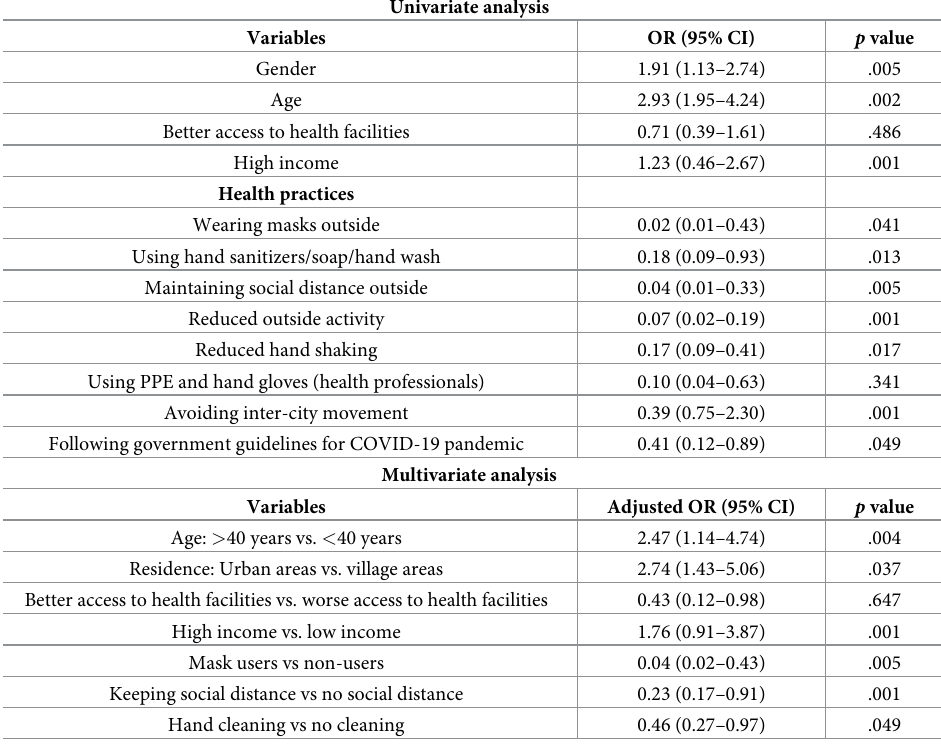
Table 4. Logistic regression analyses among the preventive measures and different parameters of COVID-19